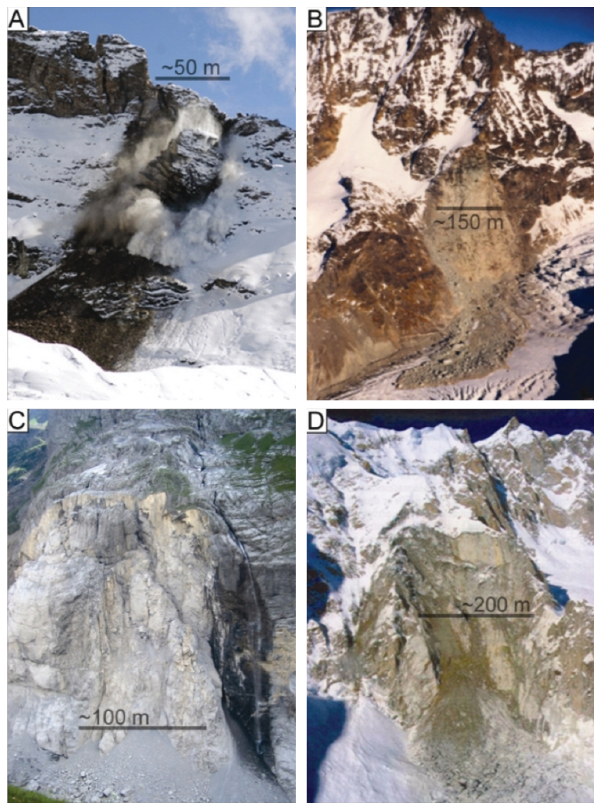
Fig. 1. Selected examples of detachment zones of recent large rockfall and rock avalanche events in the European Alps, ordered by their size. (A) K¨arpf (CH), 2007, 2 × 10 4 m 3 (O. Adolf), (B) Tschierva (CH) 1988, 3 × 10 5 m 3 (A. Amstutz), (C) Eiger (CH), 2006, 1 × 10 6 m 3 (L. Fischer), (D) Brenva (I), 1997, 2 × 10 6 m 3 (G. Mortara). Approximate scale bars indicate the size of the de- tachment